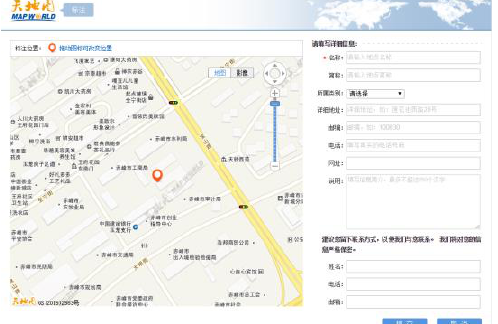
Figure 6. On-line Verification